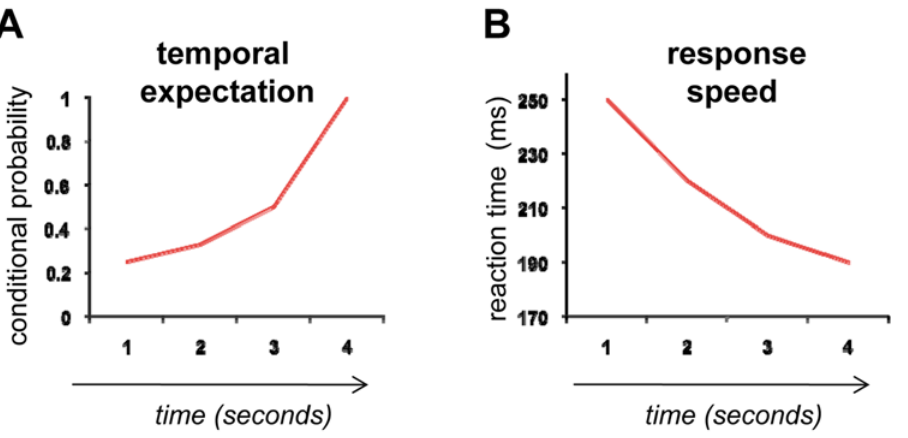
Figure 1. Increasing conditional probabilities over time speed responses. (A) If an event is likely to occur after one of four possible delays with equal probability, then the conditional probability thattheevent will occur at one of these delays evolves over time. For example, after a delay of 1 s, the probability of the event occurring is 1 in 4 (i.e., 0.25). If it does not occur at 1 s, then there are three possible delays left, now giving a 1 in 3 (i.e., 0.33) chance of occurring at the next delay. But, if it does not occur after 2 s either, there is now a 1 in 2 (i.e., 0.50) chance of it occurring at the next delay. Finally, if it has still not occurred by 3 s, then the subject can be sure that it must certainly occur (i.e., 1.0) at the final (4 s) delay. In other words, the objective probability of event occurrence combines with the predictive power of time’s arrow to produce changing conditional probabilities over time. (B) As the time (or ‘‘foreperiod’’) before an event occurs gets longer, so responses to that event get faster. The speeding of reaction time typically parallels increasing conditional probabilities over time, reflecting a state of increased preparedness to respond with passing